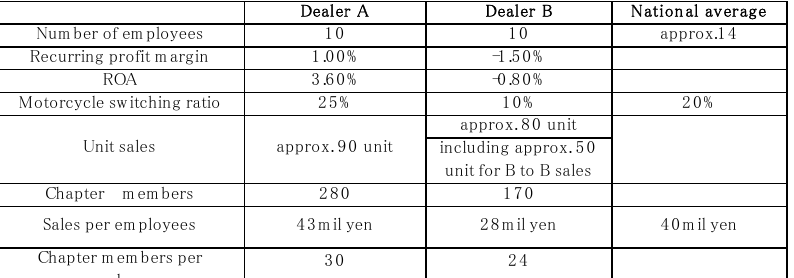
Table 3. Sales performance comparison between Dealers A and B in 2012